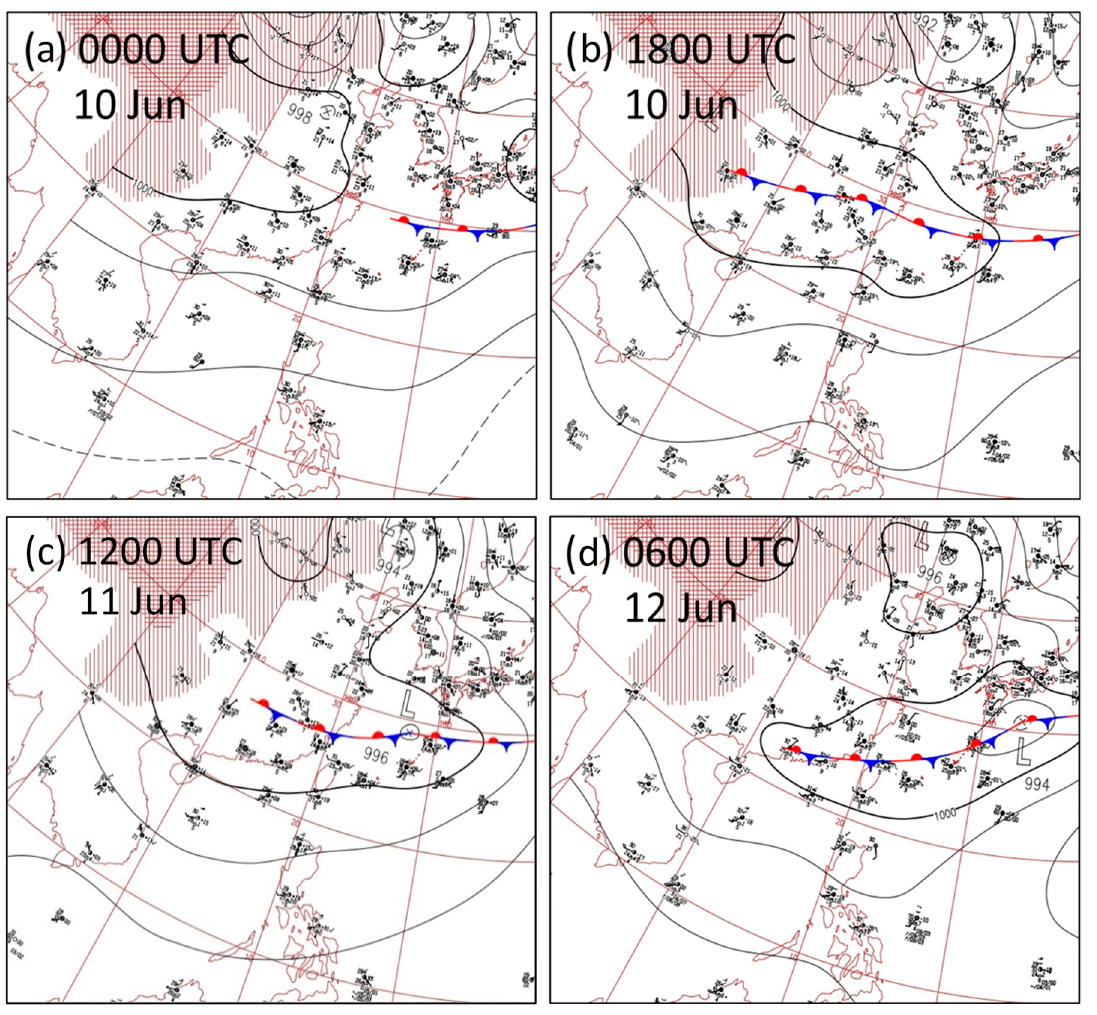
Figure 2. The JMA surface weather map at ( a ) 0000 UTC 10, ( b ) 1800 UTC 10, ( c ) 1200 UTC 11, and ( d ) 0600 UTC 12 June 2012, respectively. The Mei-yu front is depicted as